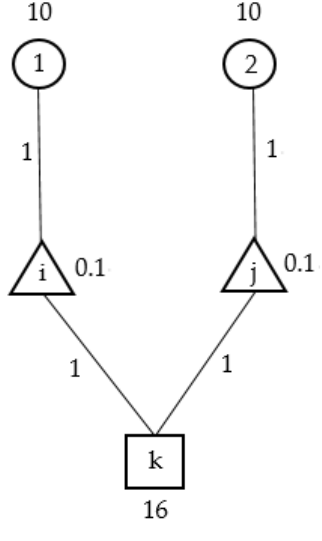
Figure 2. Fraction of a supply network.